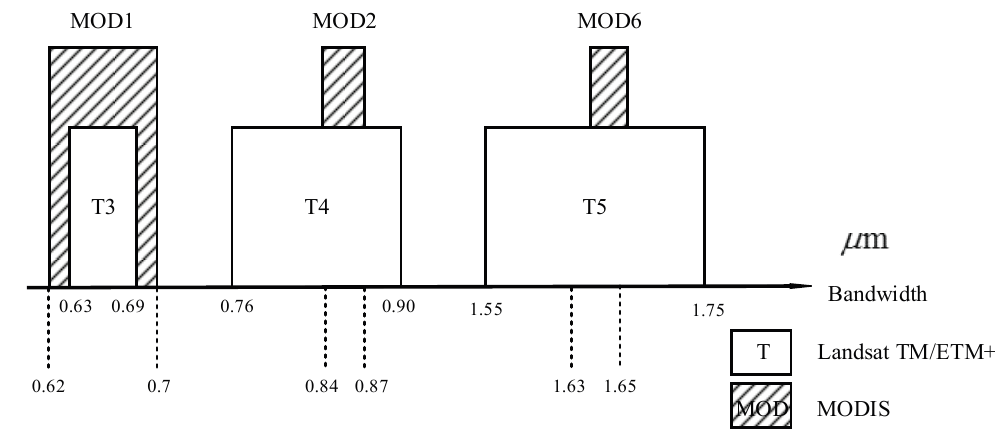
Figure 2. The CC values of the corresponding L-M pairs acquired on the same date for both the CIA and Poyang Lake sites. ( a ) The general variance of the CC at the CIA site, ranging from 0.50–0.68 for B3, 0.46–0.56 for B4, and 0.59–0.70 for B5; ( b ) The general variance of the CC at the Poyang Lake site. The CC varies from 0.50–0.77 for B3, 0.71–0.89 for B4, and 0.73–0.85 for B5.